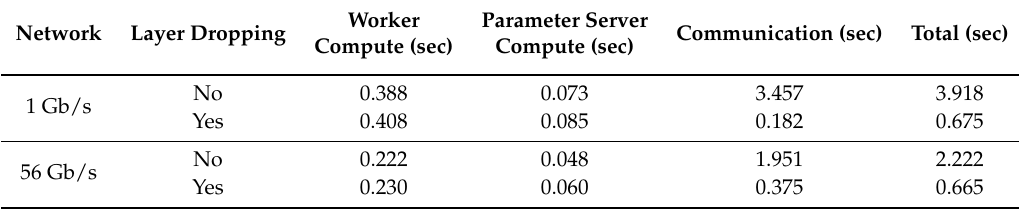
Table 1. Average execution time per